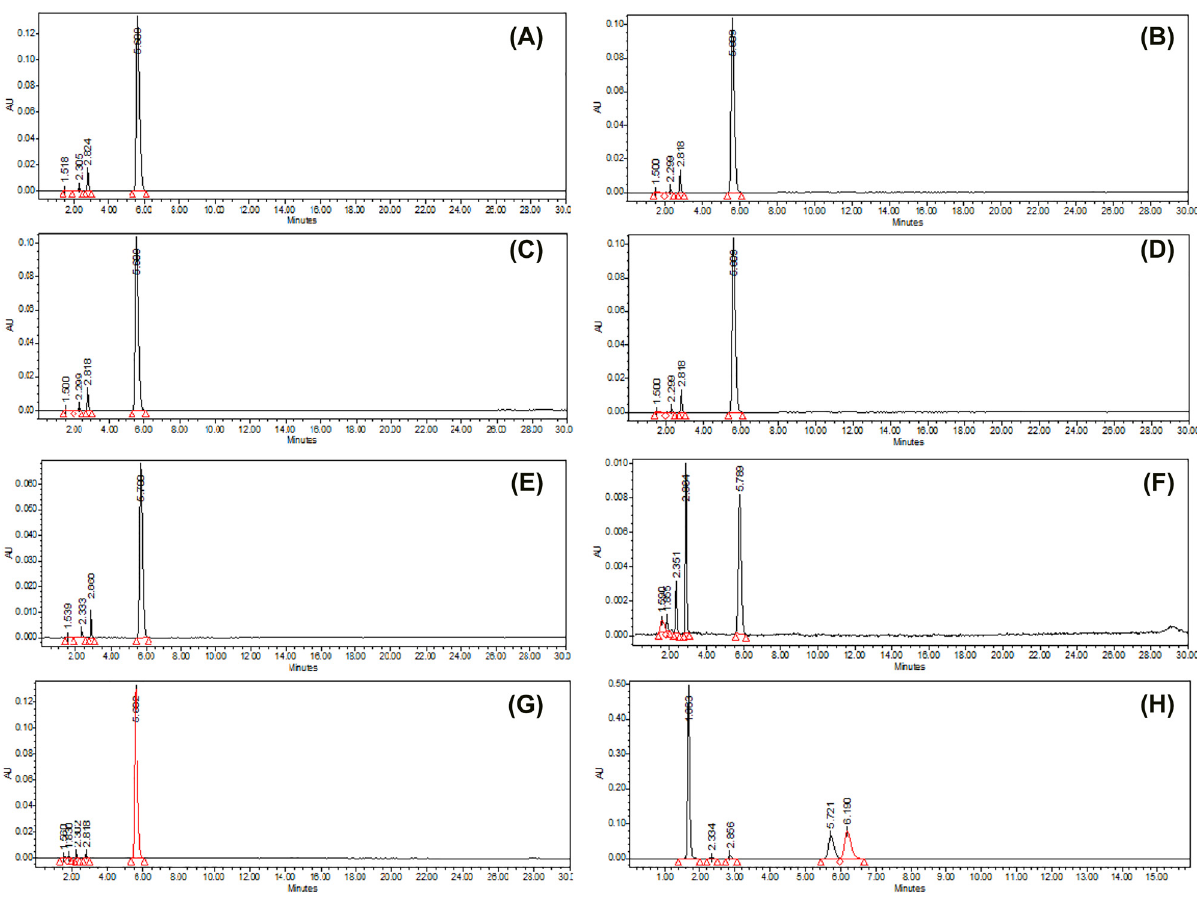
Figure4: RepresentativeHPLC-UVchromatogramsofareferenceamiodaronehydrochloridesolutionat100 μ g/mL(A)andafterstressedconditions for 1 h: heat (B), HCl 0.1 M (C), HCl 1 M (D), NaOH 0.1 M (E), NaOH 1 M (F), and after stress conditions for 3 h: H 2 O 2 3% (G) and H 2 O 2 30%